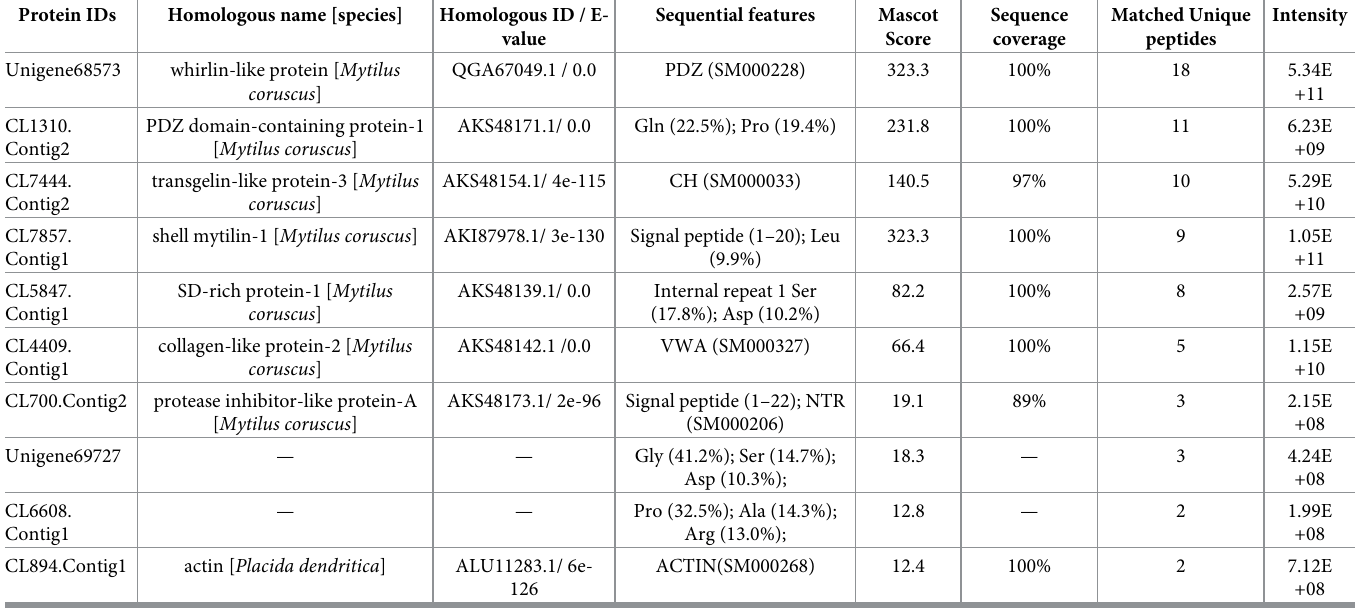
Table 1. LC-MS/MS identification of the protein partners of rWLP in the shell matrices extracted from the shell of M . coruscus by affinity adsorption using Ni-col- umn pull down. Protein